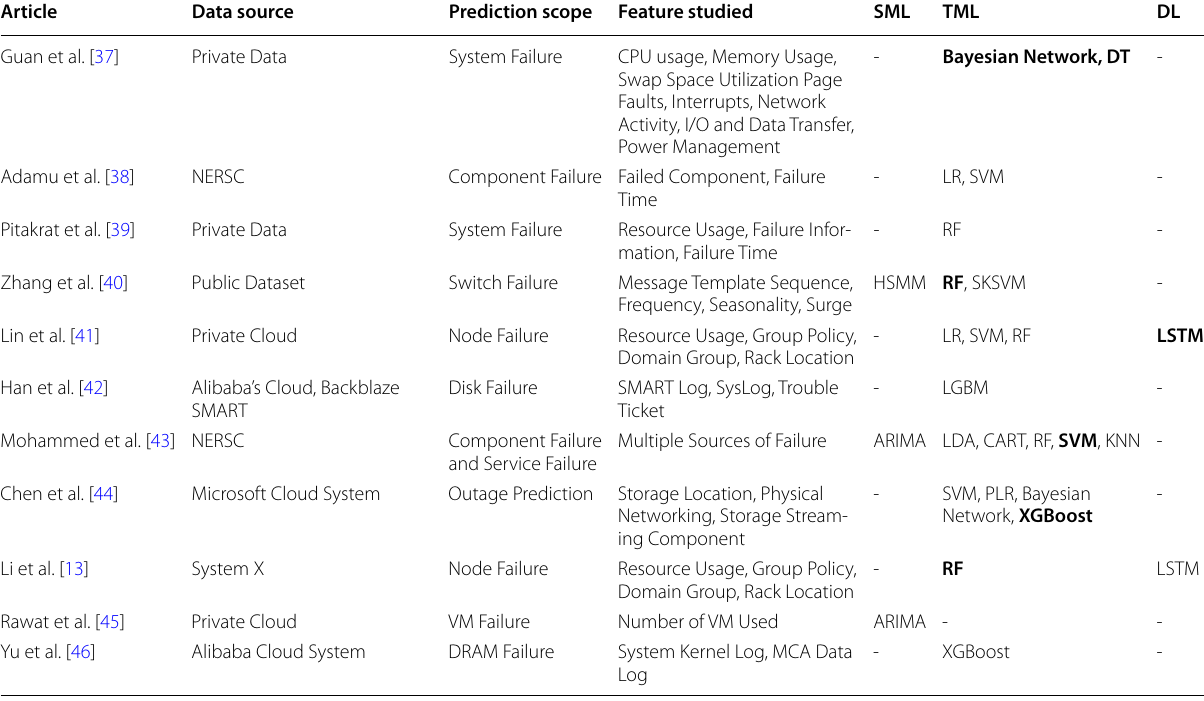
Table 9 This table presents the related works of other types of failure prediction using other datasets. The algorithm in bold refers to the best model mentioned in the respective article. [Note: SML ‑ Statistical Machine Learning Algorithms, TML ‑ Traditional Machine Learning Algorithms, DL ‑ Deep Learning Algorithms]